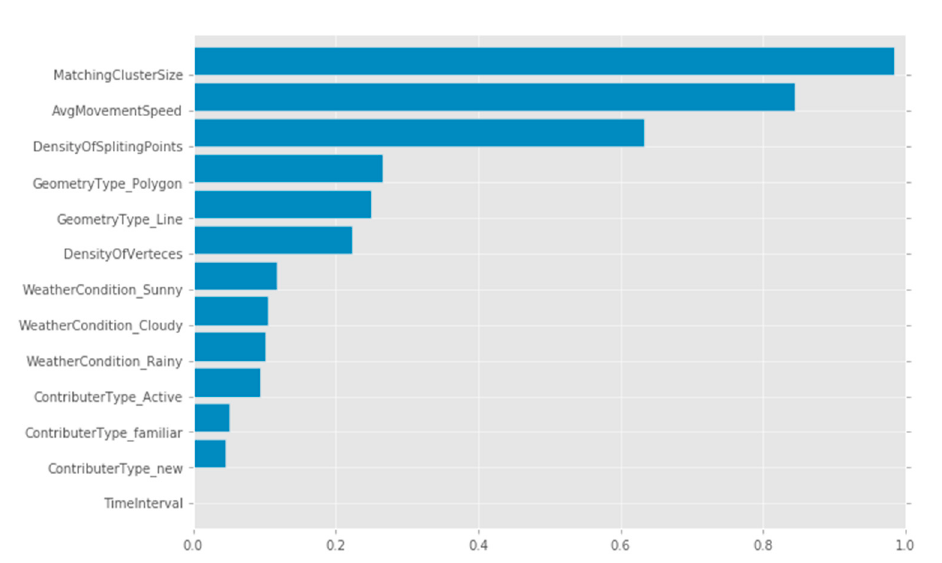
Figure 9. Normalised importance of trajectories’ features for tag identification in Random Forest method.